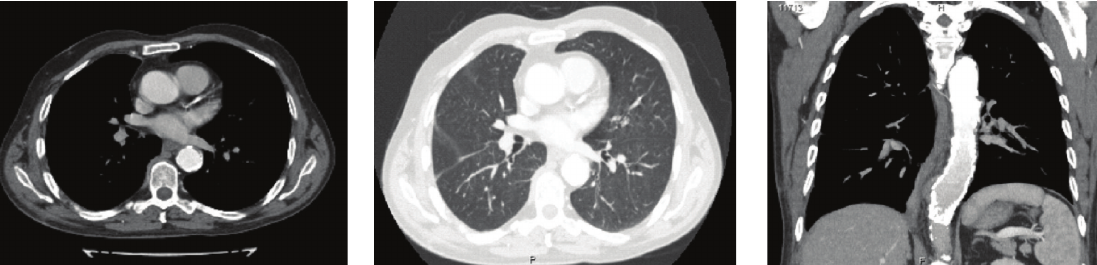
Figure 2: A follow-up CT angiography, three months later showed a smooth and patent endograft with no migration or endoleak. The lung is fully